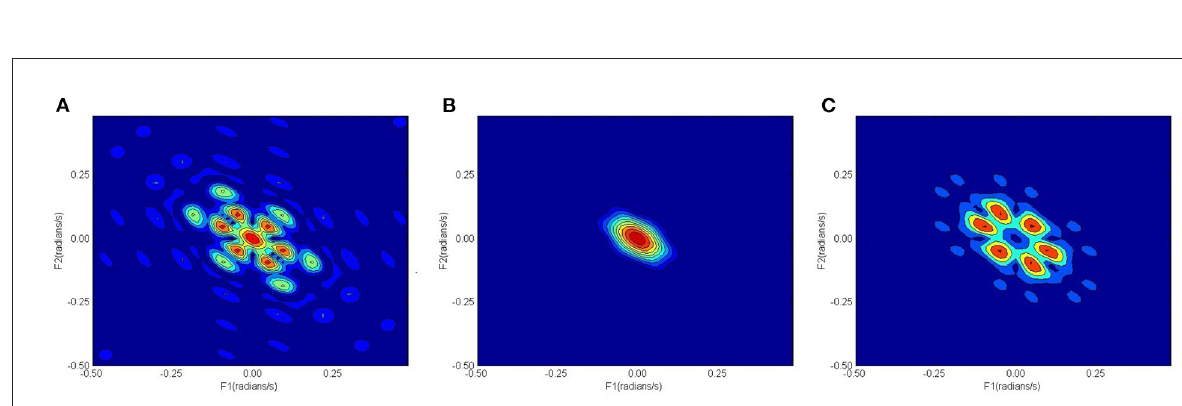
FIGURE3 Bispectrum plots, (A) normal, (B) MDDSI − , (C) MDDSI+ ECG signals.